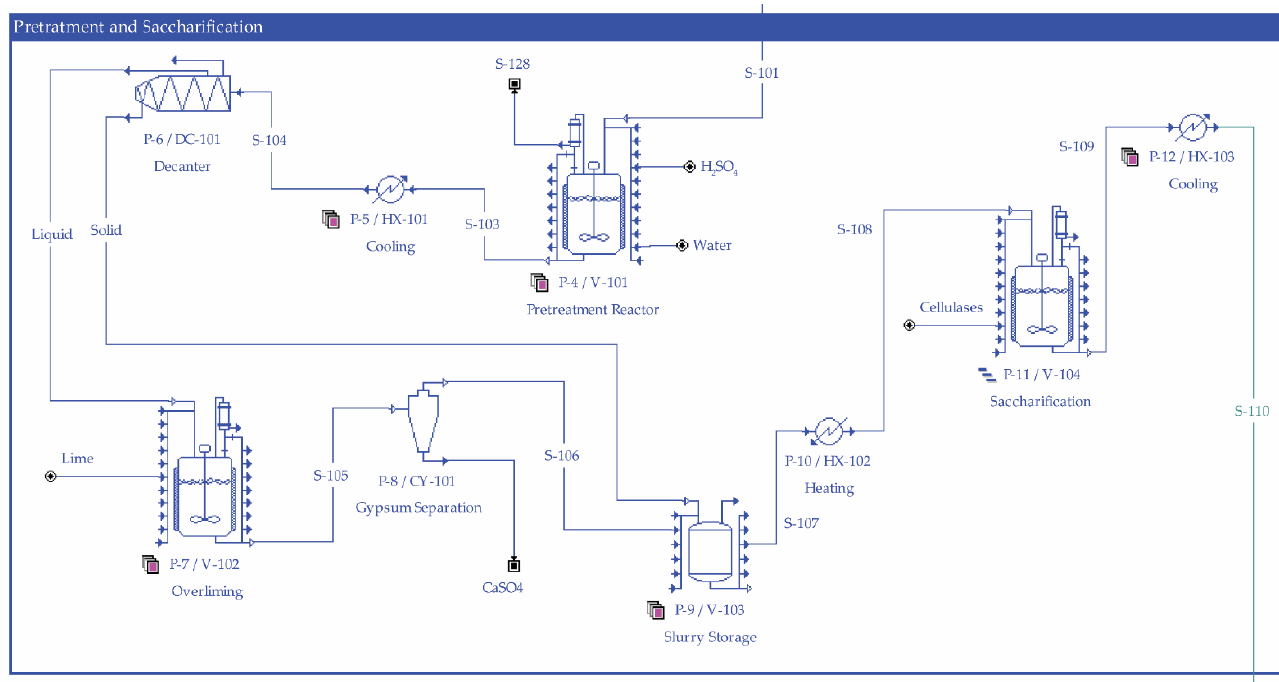
Figure 2. Process flow diagram of the bioethanol production process from spent sugar beet pulp, consisting of pretreatment (acid hydrolysis) and saccharification (enzyme hydrolysis) stages.